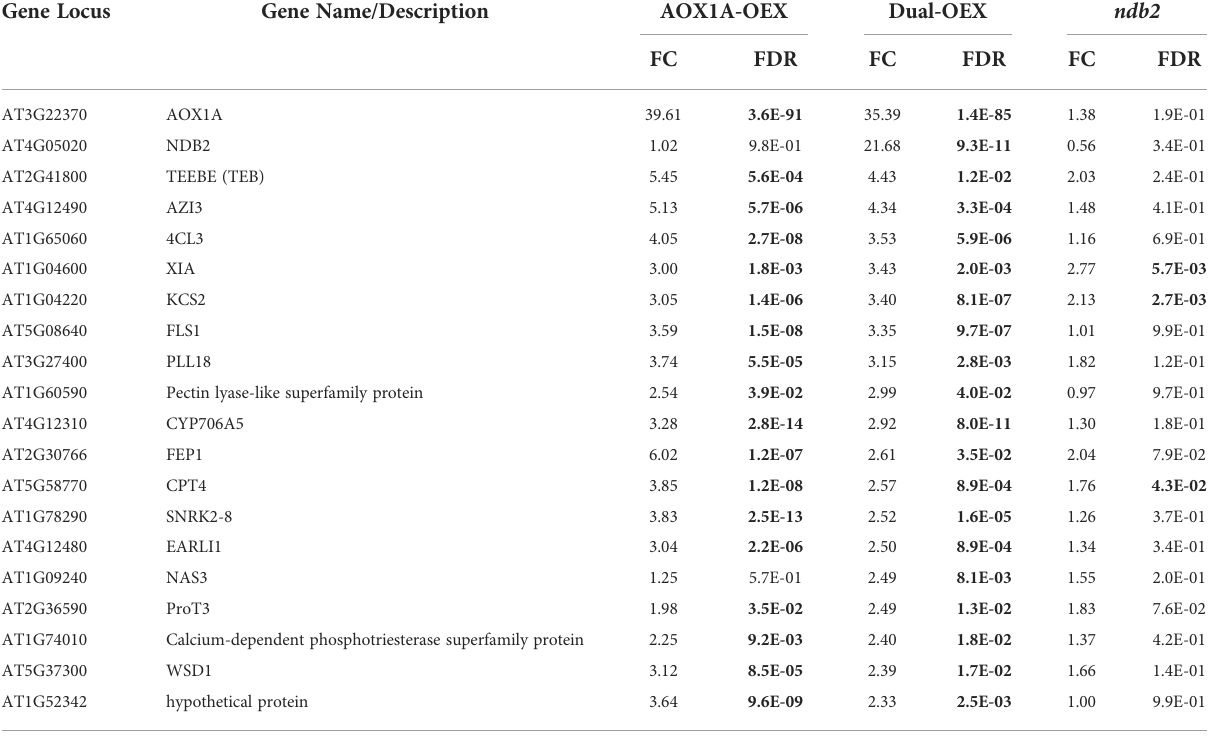
TABLE 5 Top 20 up-regulated DEGs for dual AOX1A and NDB2 overexpression line relative to wild type. Gene Locus Gene